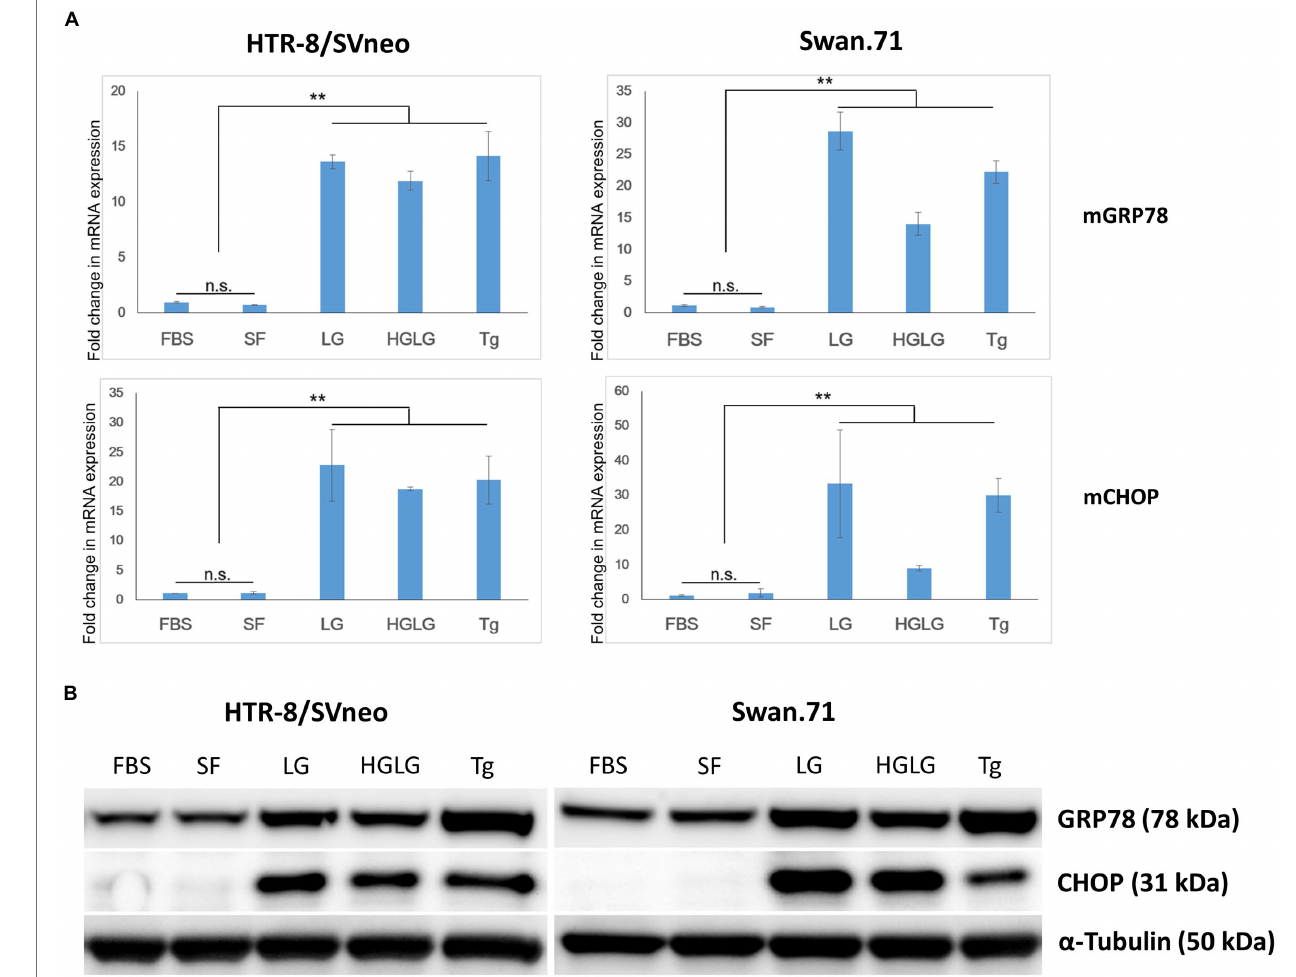
FIGURE 1 | Expression changes in ER stress-related markers in first-trimester trophoblast cells under low-glucose-induced ER stress conditions. Trophoblast cells were cultured in 6-well plates (for WB) or 24-well plates (for RNA extraction and PCR) in complete medium for 2 days before culture in LG (low glucose, 0.5 mM) medium for 24 h, HG (high glucose, 25 mM) medium for 6 h, and then LG medium for an additional 18 h. The cells cultured in SF medium (serum-free, RPMI/0.1% BSA) were used as a negative control. The cells cultured in complete medium (FBS) or in SF medium containing 25 nM thapsigargin (Tg) for 24 h were used as comparative references. (A) Enhancement of GRP78 and CHOP mRNA expression. The results are representative of three independent experiments. ** p < 0.01. (B) Increased expression of the ER stress-related markers GRP78 and CHOP by Western